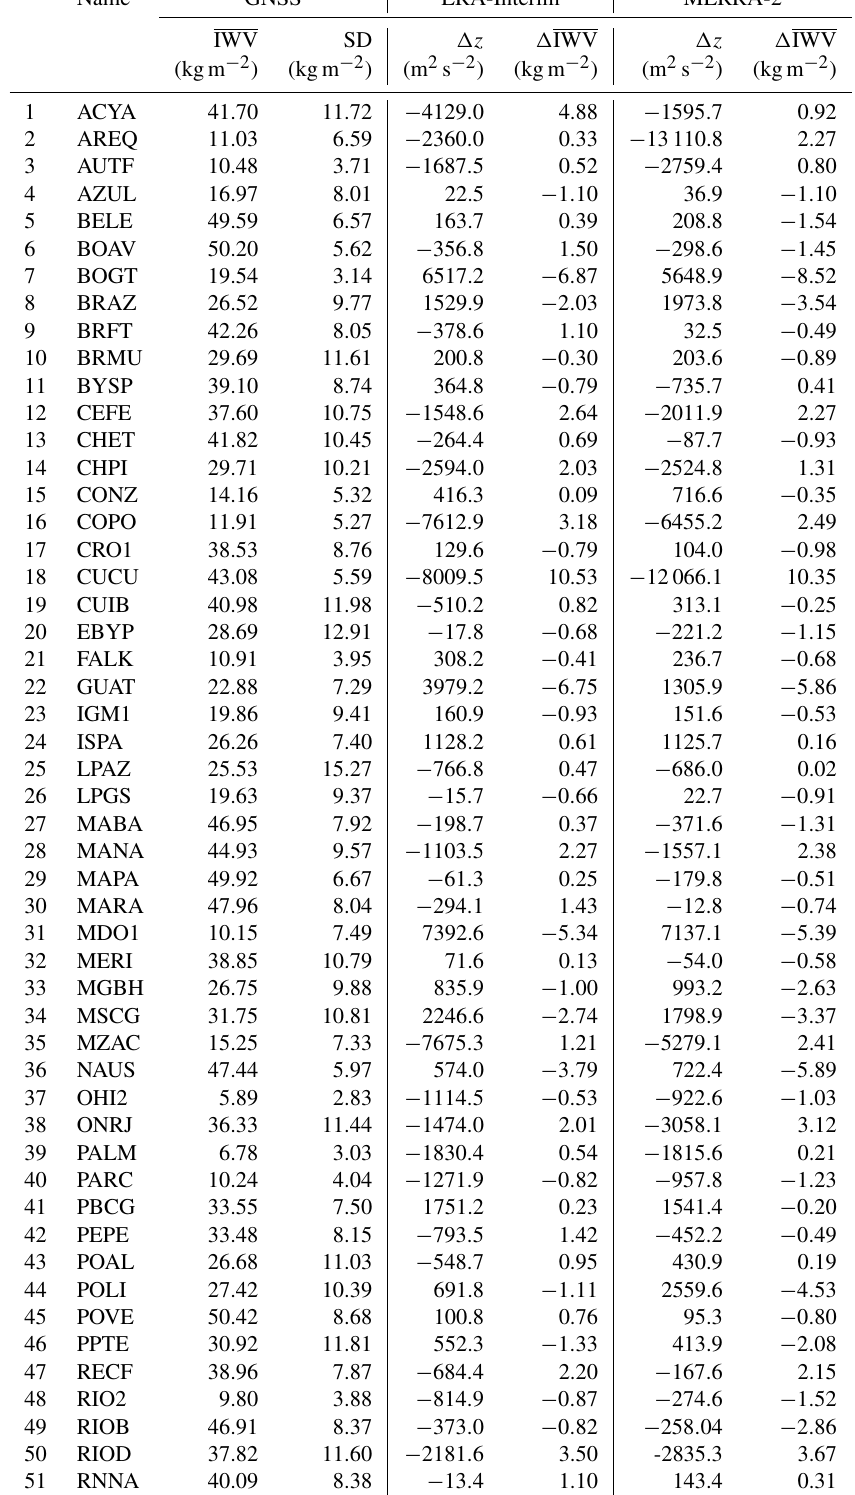
Table 2. Differences of the mean values of IWV ( (cid:49) IWV) between GNSS and the NWM for the period from 2007 to 2013 at 67 stations located in South and Central America. The mean value (IWV) from GNSS at each site is also given, and SD refers to the standard deviation. (cid:49)z = z GNSS − z NWM refers to the difference in the geopotential at each GNSS